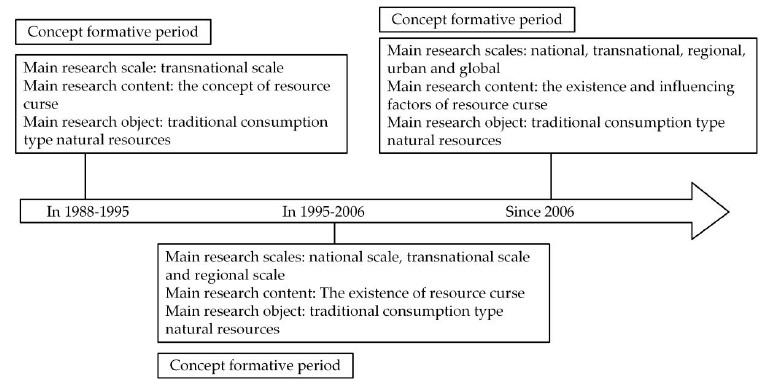
Figure 1. The development history of the resource curse research.